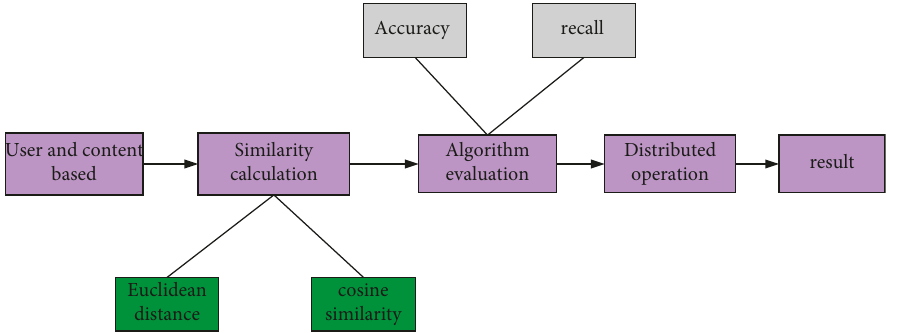
Figure 4: Recommendation